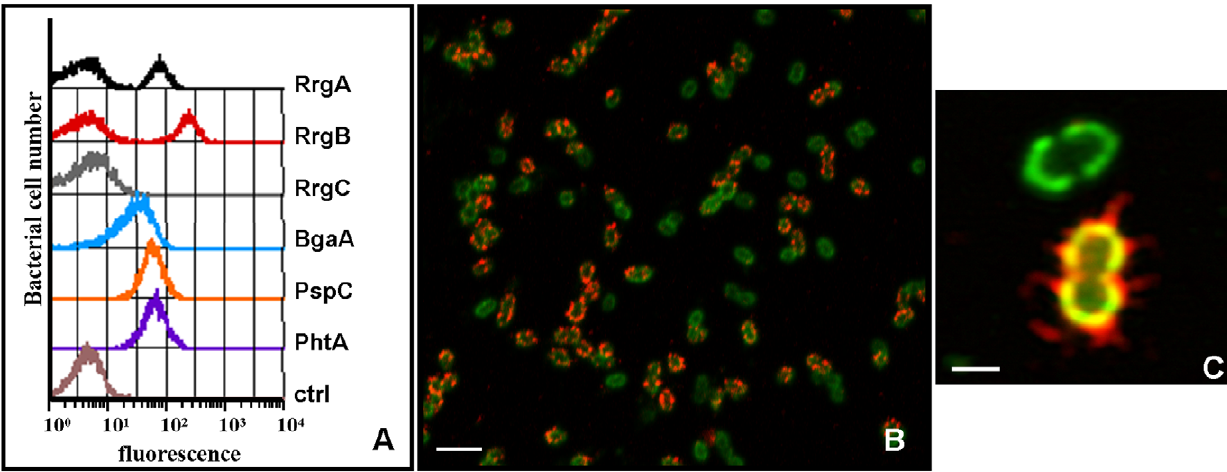
Figure 1. Pilus components display a biphasic expression pattern. A) TIGR4 bacteria were labeled with anti-RrgA, RrgB clade I, RrgC, BgaA (beta-galactosidase), PhtA (pneumococcal histidine triad protein A) or PspC (pneumococcal surface protein C, also known as CbpA,) primary antibodies (1:400 dilution), and with FITC anti-mouse IgG secondary antibodies (1:100 dilution). Bacterial staining was analyzed by flow cytometry (FACS-Calibur). Sera of mice immunized with PBS were used as negative control. B,C) TIGR4 bacteria were processed for immunofluorescence, stained with mouse anti-RrgB antibodies (1:2000 dilution) (red) and with S. pneumoniae anti-capsular antibodies (Omniserum 1:2000 dilution) (green). Imaging was performed with a confocal microscope. Scale bar is 4 m m in panel B and 1 m m in panel C.